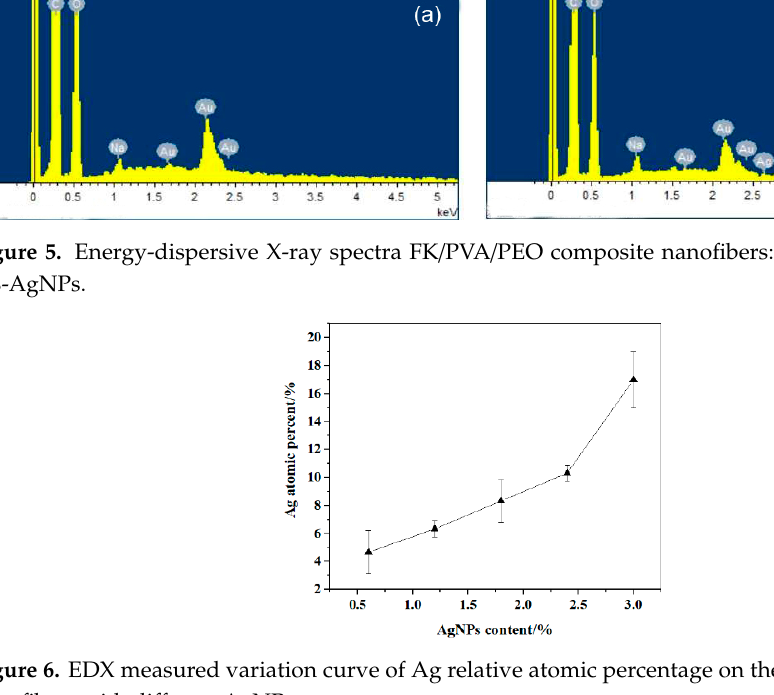
6 of 13 Figure 4. TEM images of FK/PVA/PEO composite nanofibers: ( a ) 0%-AgNPs, ( b ) 0.6%-AgNPs, ( c ) 1.2%-AgNPs, ( d ) 1.8%-AgNPs, ( e ) 2.4%-AgNPs, ( f ) 3.0%-AgNPs. 3.2. EDX Analysis EDX was used to analyze the elemental constitution of composite nanofibers. The results are shown in Figures 5 and 6. Figure 5a shows that the FK/PVA/PEO composite nanofibers (0%-AgNPs) were primarily composed of C, O, Na, and Au elements. The existence of Na came from the NaOH solution when dissolving the FK powders for preparing electrospinning solutions. The existence of Au element was because of the Au coated on the surface of the samples before SEM analysis to